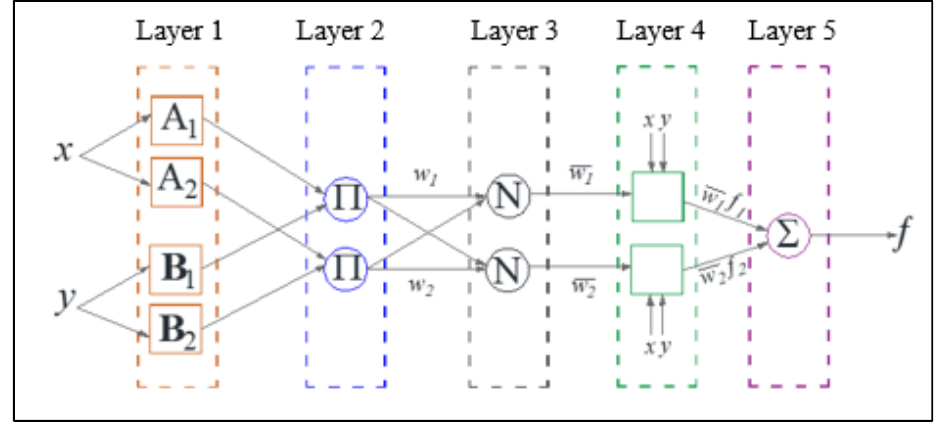
Figure 8. Architecture of the ANFIS model.